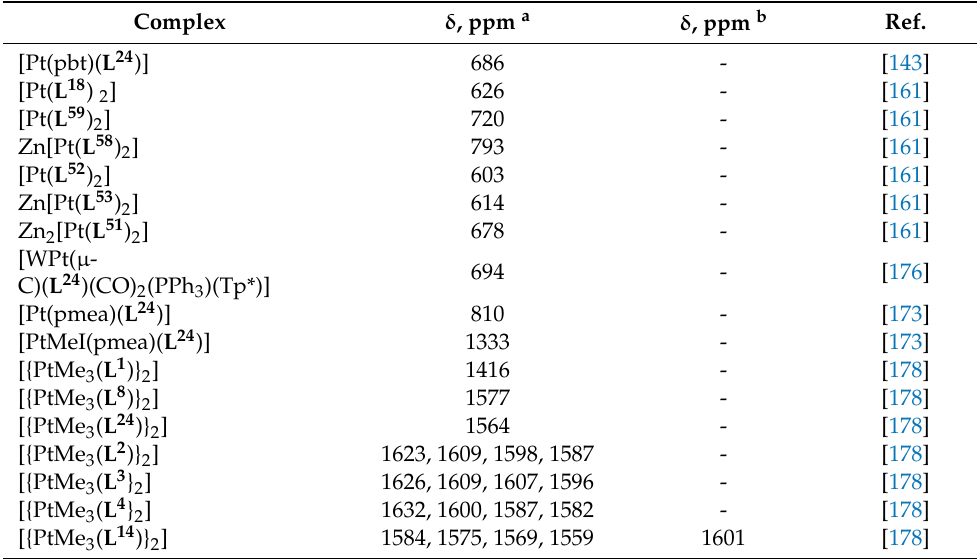
Table 11. 195 Pt NMR data reported for selected Pt(II) and Pt(IV) dithiocarbamate complexes. Complex δ , ppm a δ , ppm